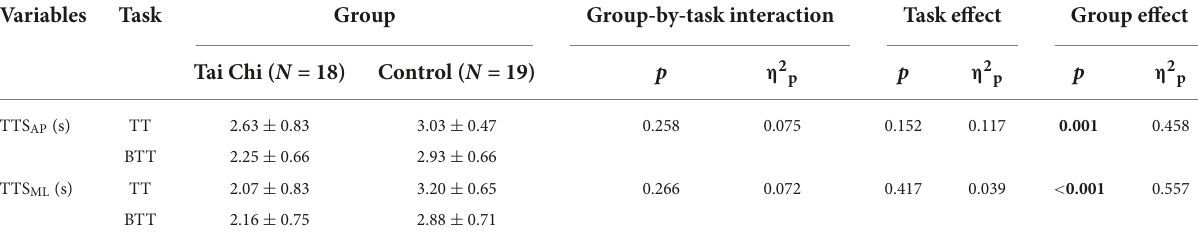
TTS AP during the TT ( r = 0.550, p = 0.018) and BTT ( r = 0.564, p = 0.015), and moderately correlated to D maxAP during the TT ( r = –0.468, p = 0.05); Among the control group, sensitive ankle proprioceptions during dorsiflexion ( r = 0.492, p = 0.033) and plantarflexion ( r = 0.519, p = 0.021) were moderately to strongly correlated to less TTS ml during the